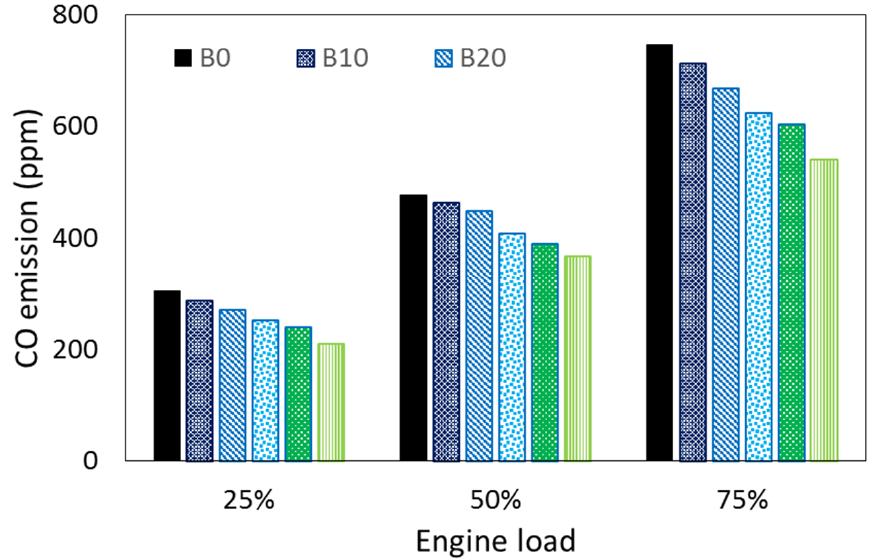
Figure 8. Effect of biodiesel on CO emission.